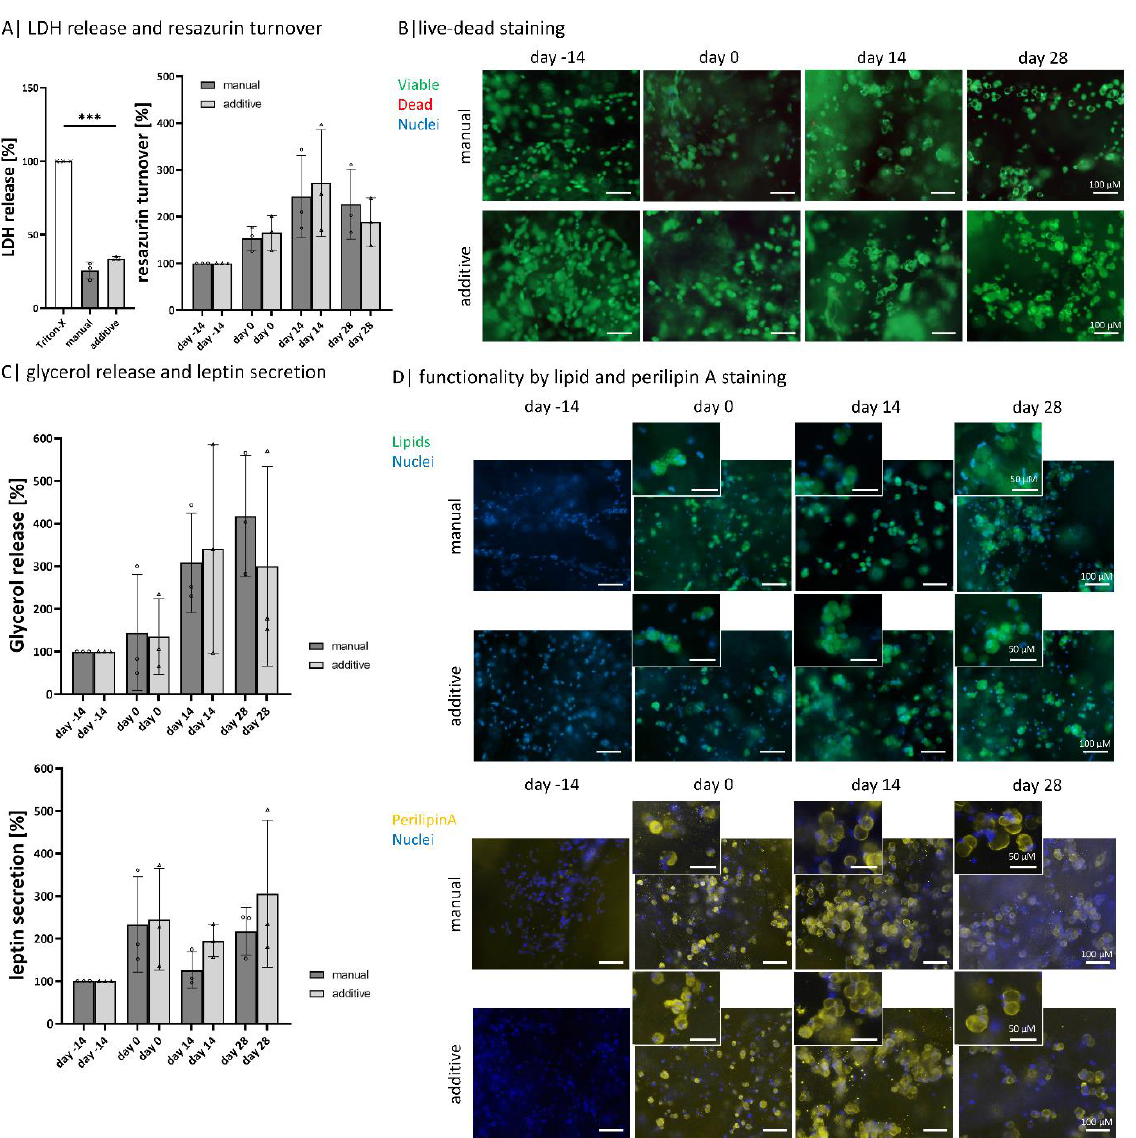
Figure 5. Comparison of bioprinted and manual models: Compared analysis of encapsulated diffASCs days − 14, 0, 14, and 28 in ( A ) live-dead staining, viable cells ins green, dead cells in red, scale bar 100 µ m ( B ) quantitative LDH release and resazurin turnover, n = 3, *** p ≤ 0.001; ( C ) normalized glycerol release and leptin secretion, n = 3; ◦ , ∆ sample values, ( D ) staining of intracellular lipids (in green, nuclei in blue) and perilipin A (in yellow, nuclei in blue) as functionality marker, scale bar 100 µ m for magnification 50 µ